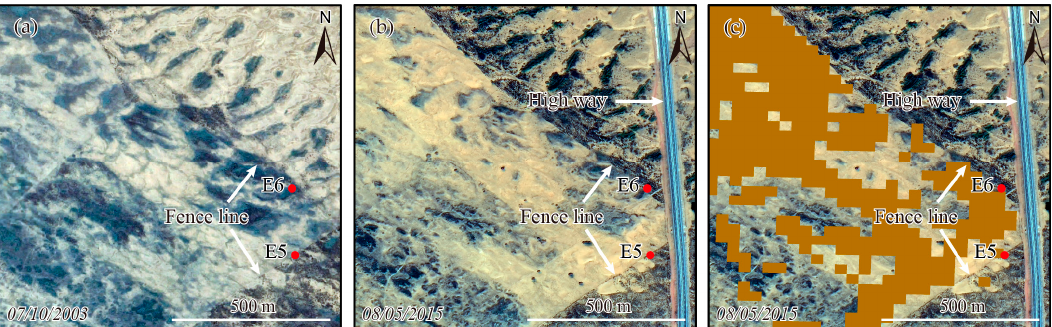
Figure 13. Satellite images showing the desertification expansion caused by stock breeding in Otog Front Banner, Ordos. ( a ) Google Earth image acquired in 2003; ( b ) GF-2 image acquired in 2015; ( c ) the area of human-induced desertification (brown color) during 2006 to 2015. The red dots marked E5 and E6 show the locations of the photos used in Figure 14a,b.